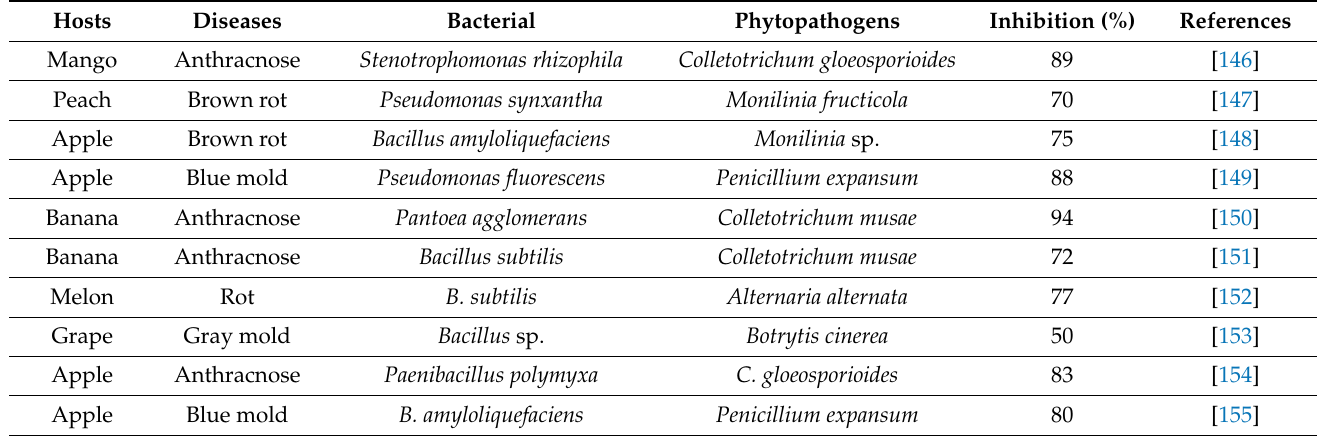
Table 4. Postharvest disease biological control employing bacterial